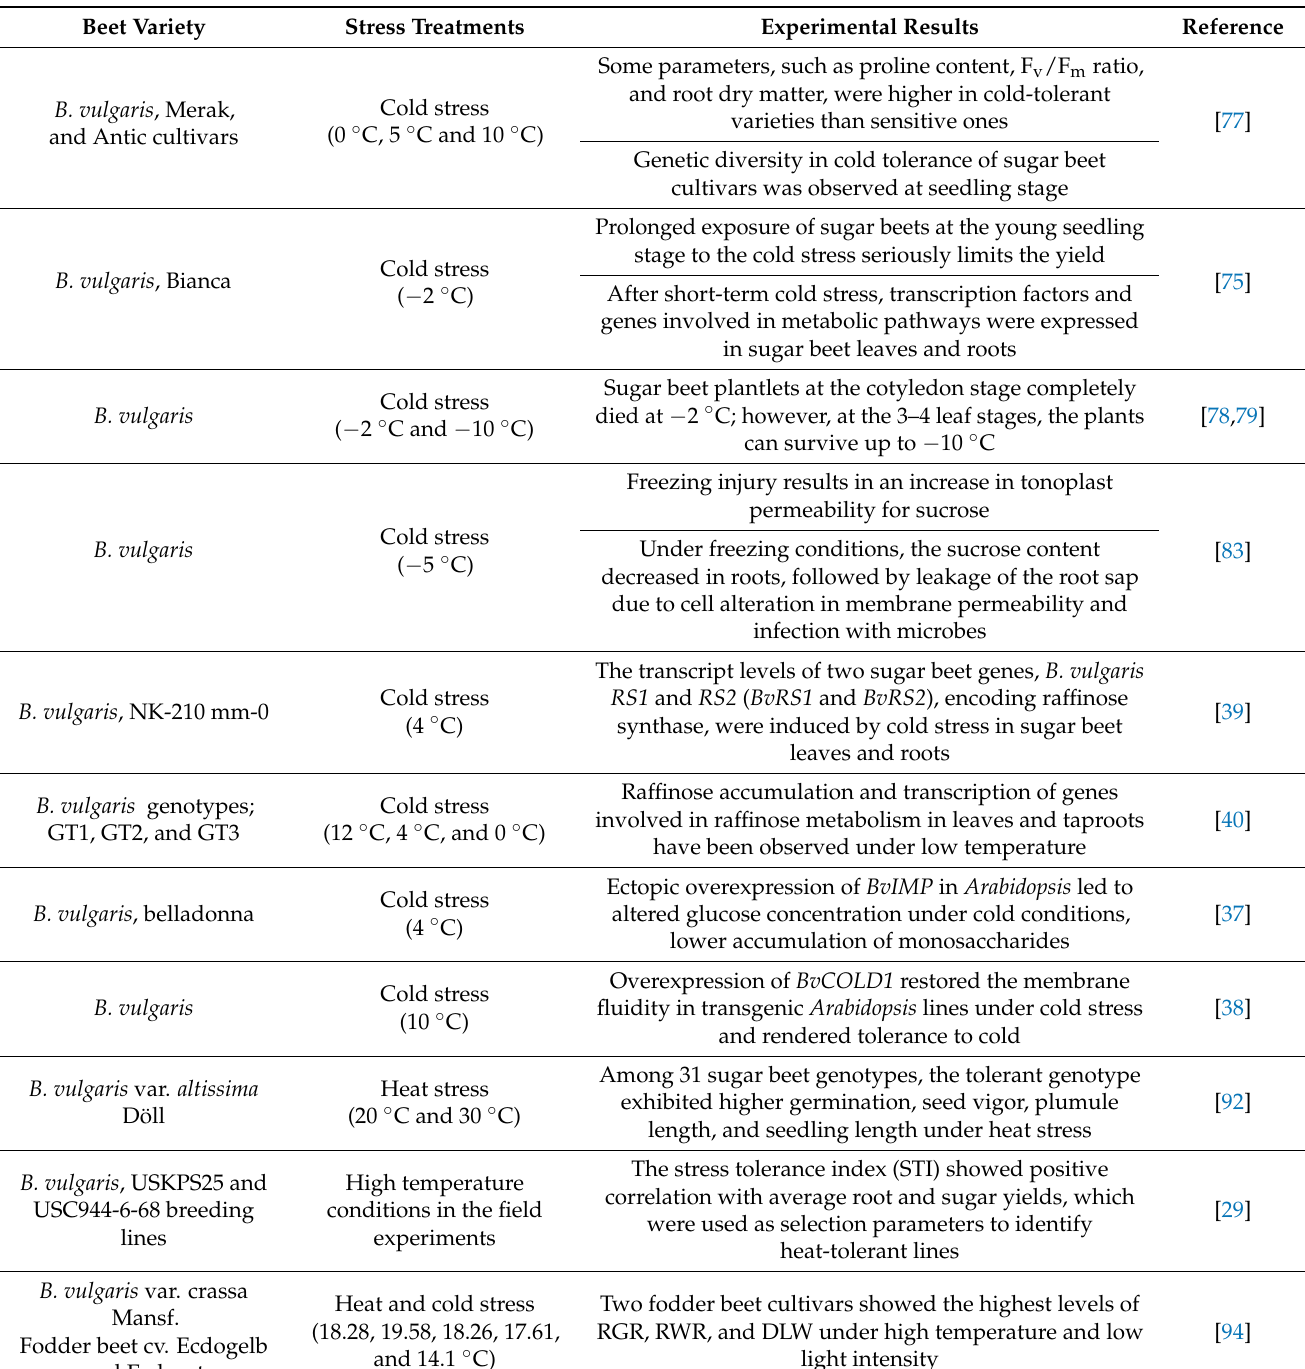
Table 3. Cold and heat stress responses in cultivated